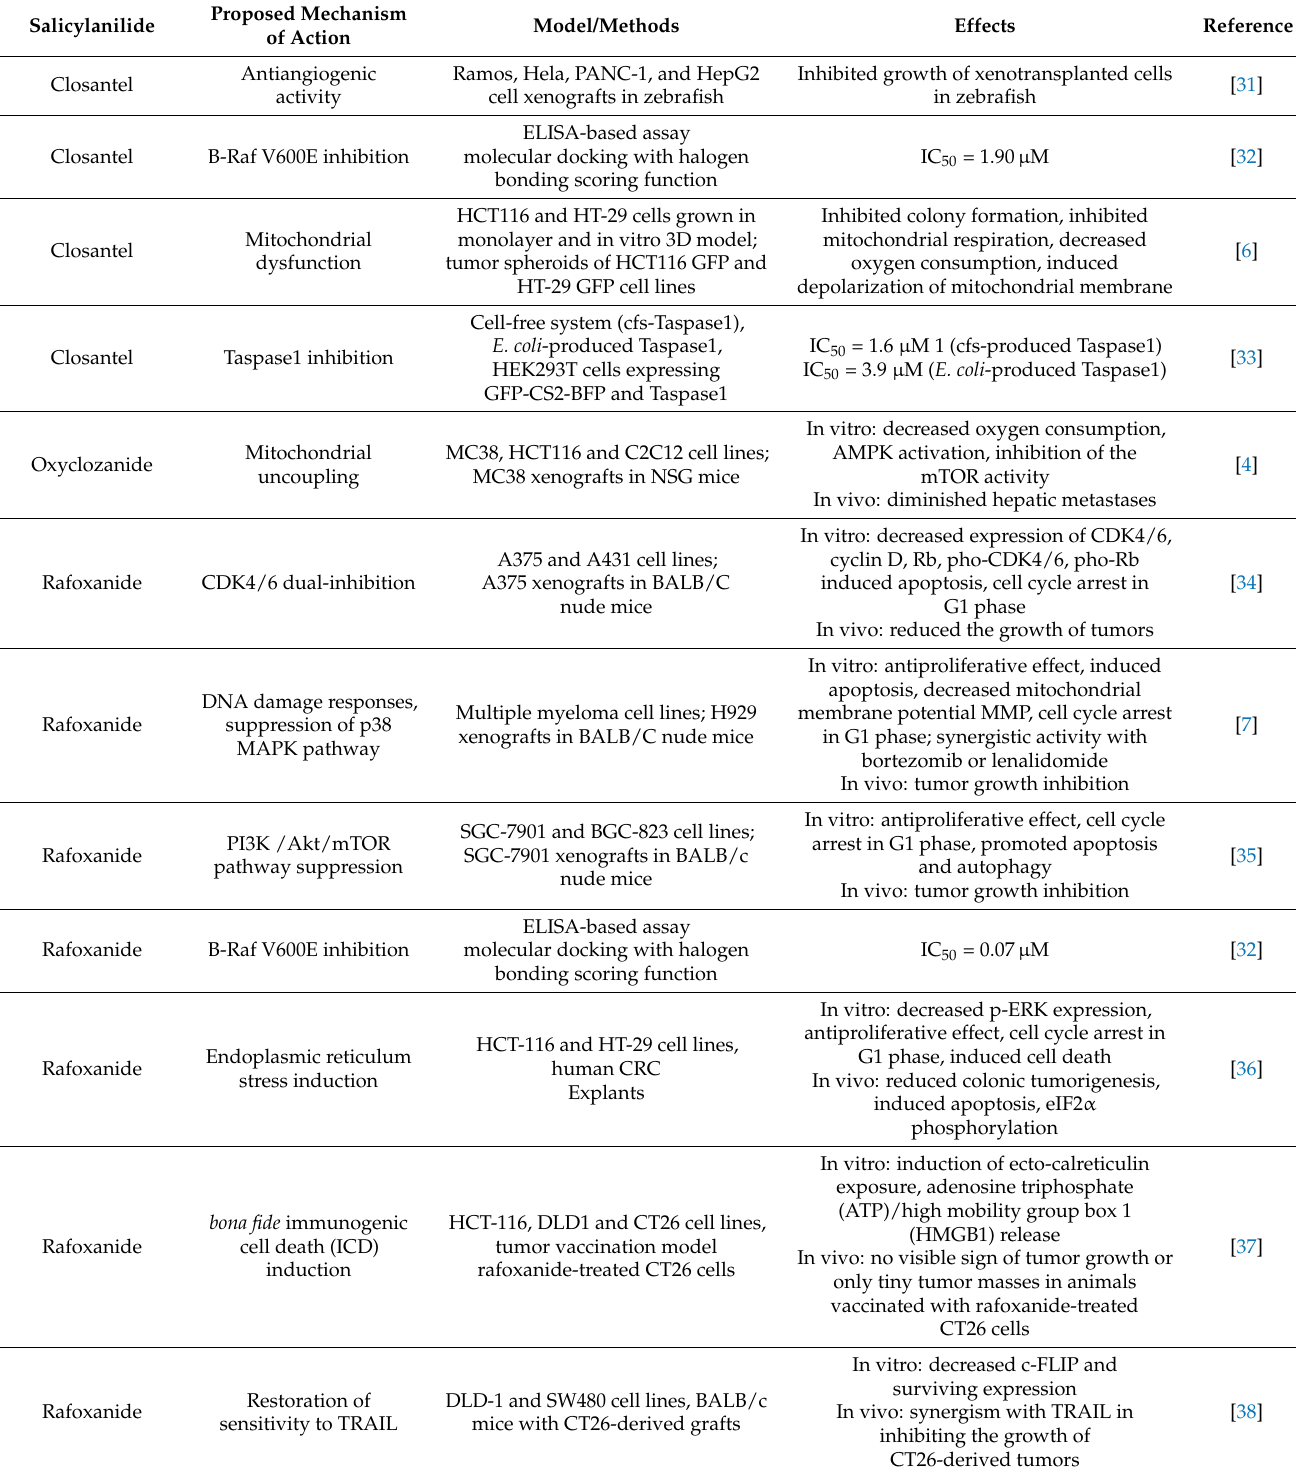
Table 1. List of studies focused on anticancer properties, including proposed mechanism of action and detailed effects of salicylanilide compounds closantel, oxyclozanide, rafoxanide,